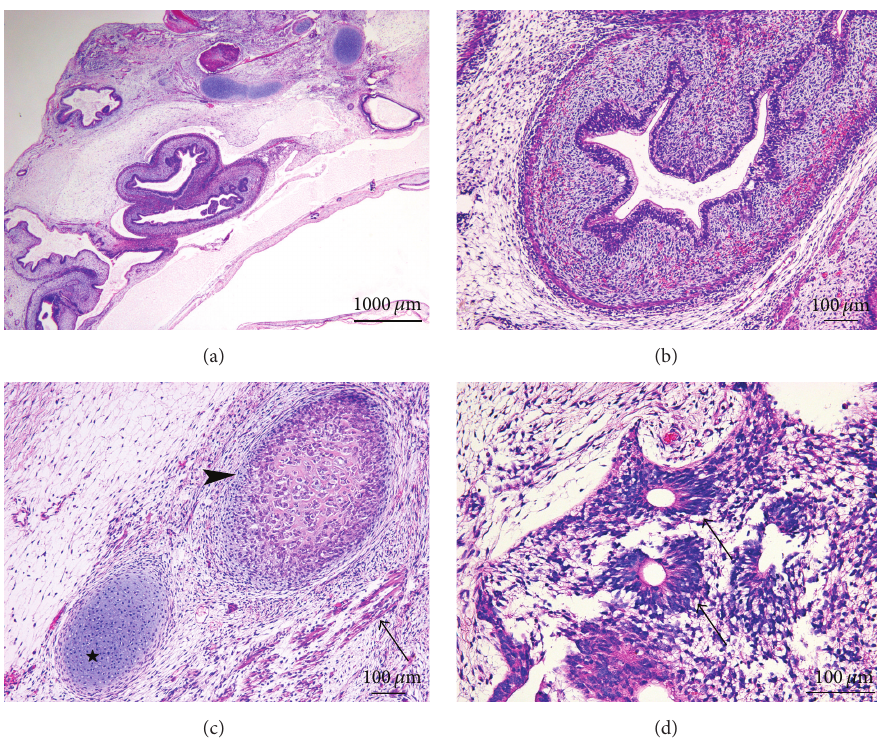
Figure 5: iPSC generated from human fibroblasts. The tumors generated were mainly cystic (a, H&E 20x), and derivatives from all three germ cell layers were seen. Intestinal type structures were lined by a mucin producing epithelium, overlying a well-differentiated wall with a smooth muscle layer (b, H&E 100x). Mesodermal derivatives also consisted of immature bone (osteoid) ( arrowhead ) and cartilage ( star ), as well as striated muscle ( arrow ) (c, H&E 100x). Ectodermal derivatives corresponded mainly to immature neuroglial tissue and neuroectodermal rosettes ( arrows ) (d, H&E